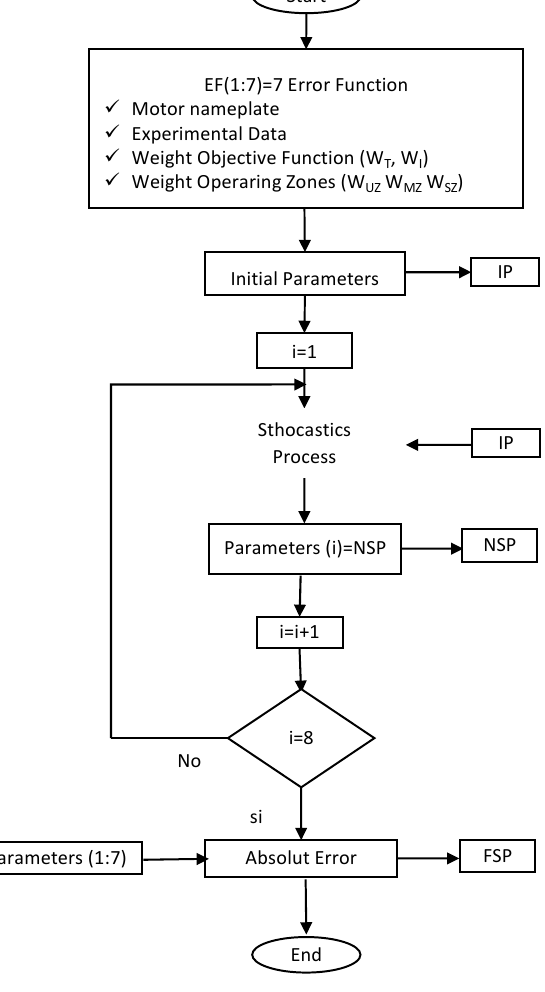
Figure 8. Flowchart of the algorithm that implements the SSVDC technique.